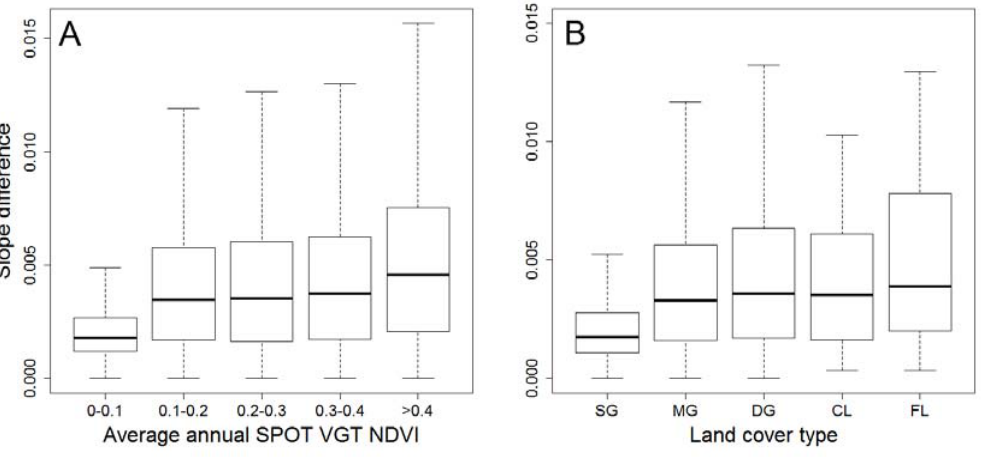
Figure 5. Boxplots of absolute differences between regression (Sen’s) slopes derived from SPOT VGT and AVHRR GIMMS time series grouped by land cover types ( A ) and SPOT VGT-based NDVI intervals ( B ). See Table 1 for a description of land cover types. The boxes represent first (25%) and third (75%) quartiles; the whiskers are defined as 1.5 times interquartile. The bold horizontal line in the box represent